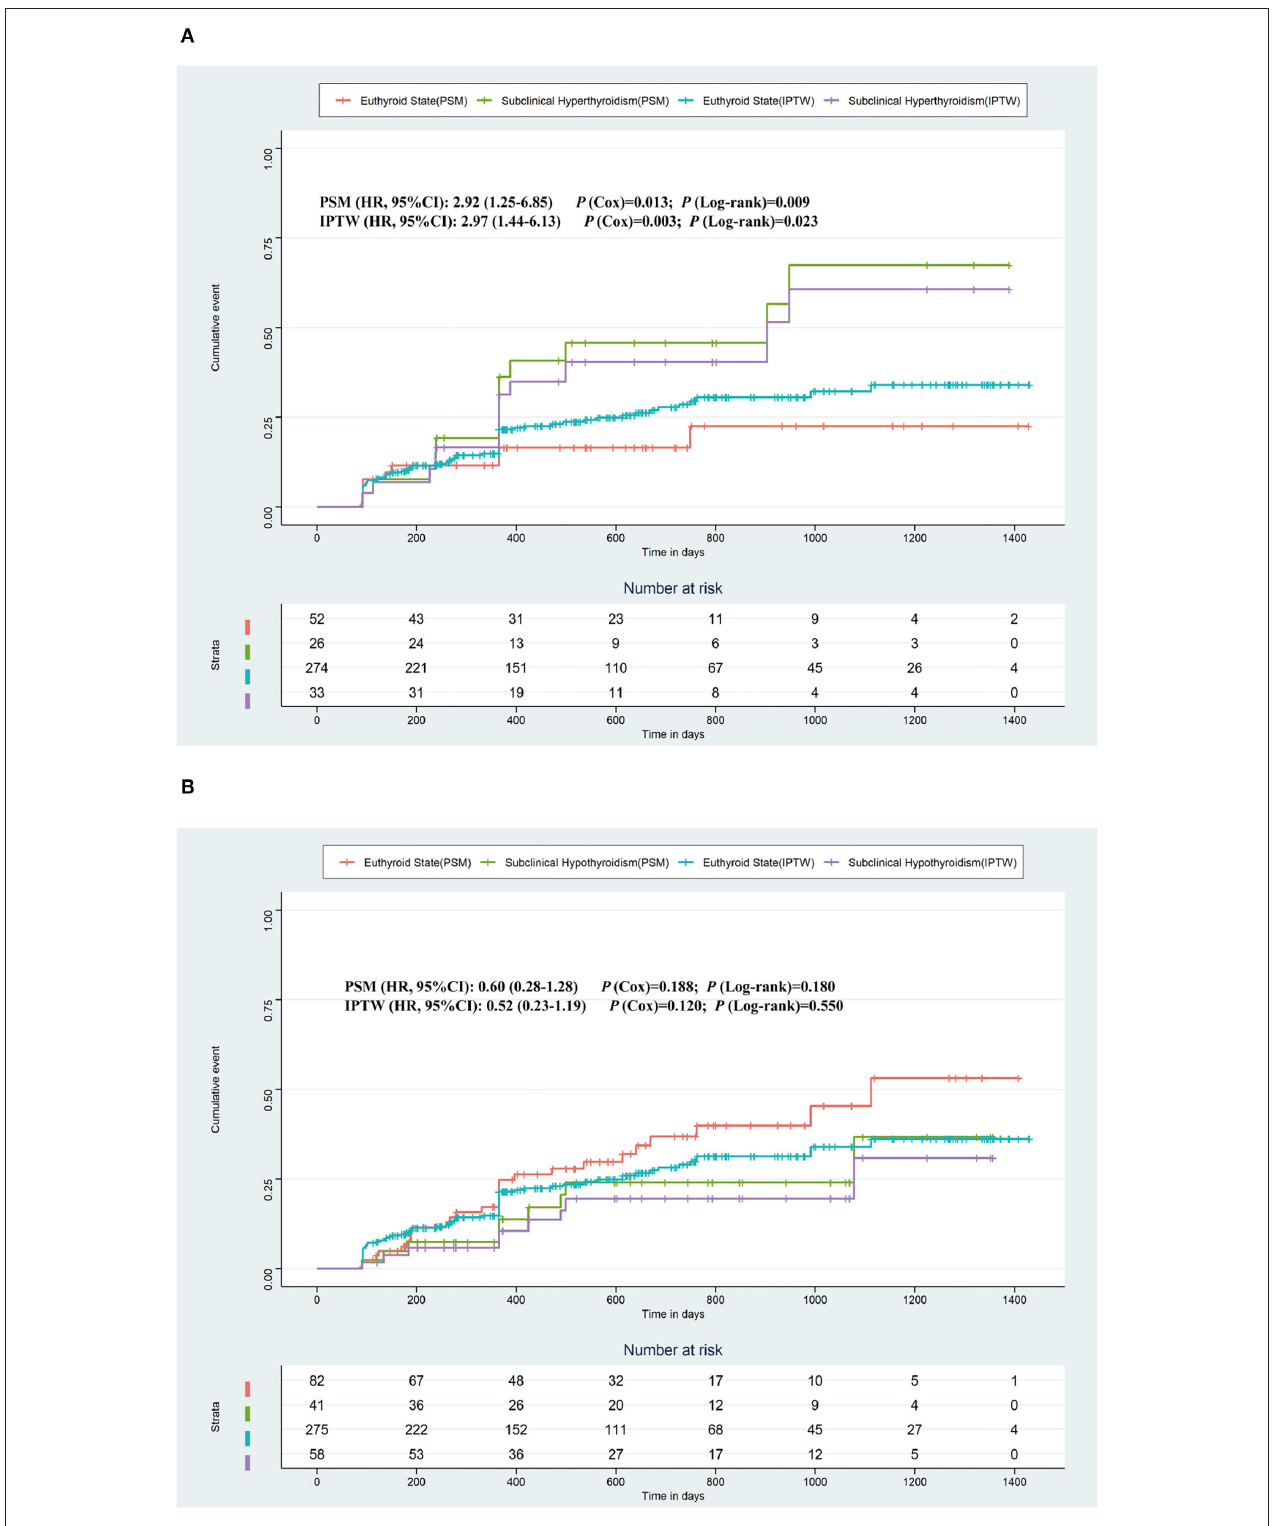
FIGURE 3 | Kaplan–Meier plot estimates of the rate of recurrence of atrial fibrillation based on PSM and IPTW. (A) Kaplan–Meier plot estimates of the rate of recurrence of atrial fibrillation in the populations who were with subclinical hyperthyroidism or the euthyroid state. (B) Kaplan–Meier plot estimates of the rate of recurrence of atrial fibrillation in the populations who were with subclinical hypothyroidism or the euthyroid state. PSM, propensity score matching; IPTW, inverse probability treatment weighting.